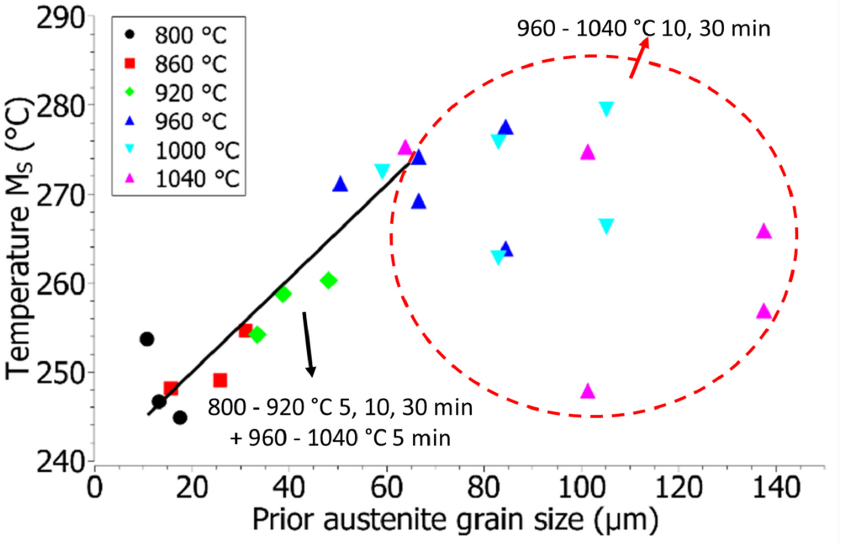
Figure 11. M S and prior austenite gran size, the connection is clear at lower temperatures, and short term high temperature austenitisation, but the scattering becomes a problem at high temperatures and longer